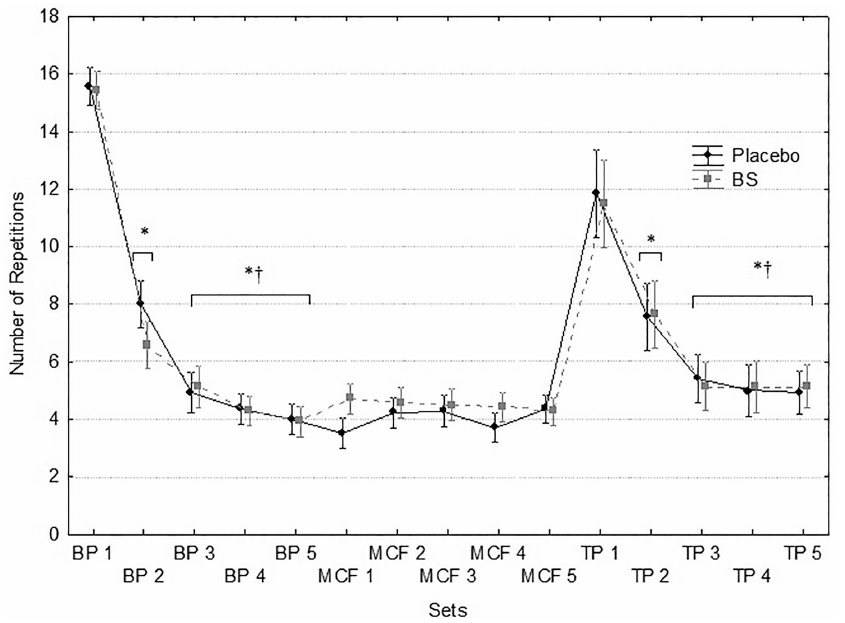
Figure 2 - Number of repetitions each set and exercise with or without supplementation (Data are mean ± SD). BP = Bench press; MCF = Machine chest fly; TP = Triceps pushdown ; BS = Bicarbonate supplementation; * Significant difference to the Pre (p ≤ 0.05).; † Significant difference to the Post (p ≤ 0.05).